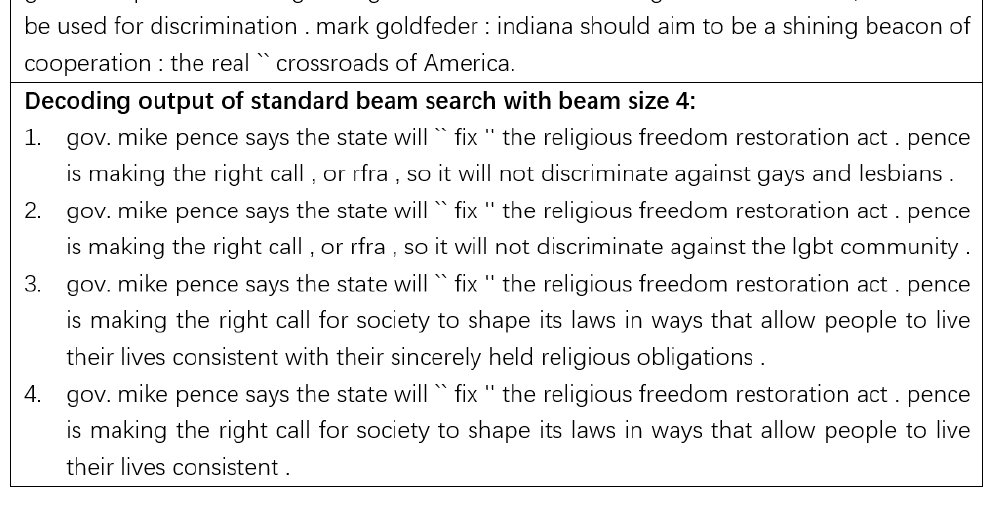
Figure 1. Example from the CNN/Daily Mail test dataset showing the outputs of the standard beam search